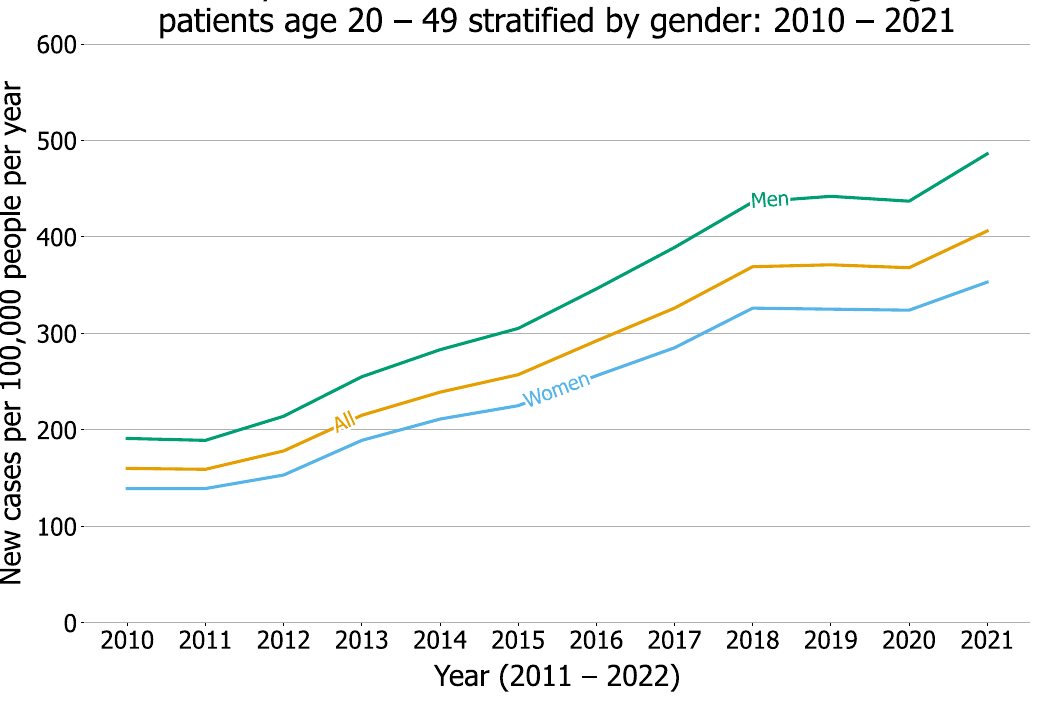
Figure 1. Yearly incidence rate of diverticular disease (measured by new cases per 100,000 people per year) between 2010 and 2021 among young adults aged 20–49.